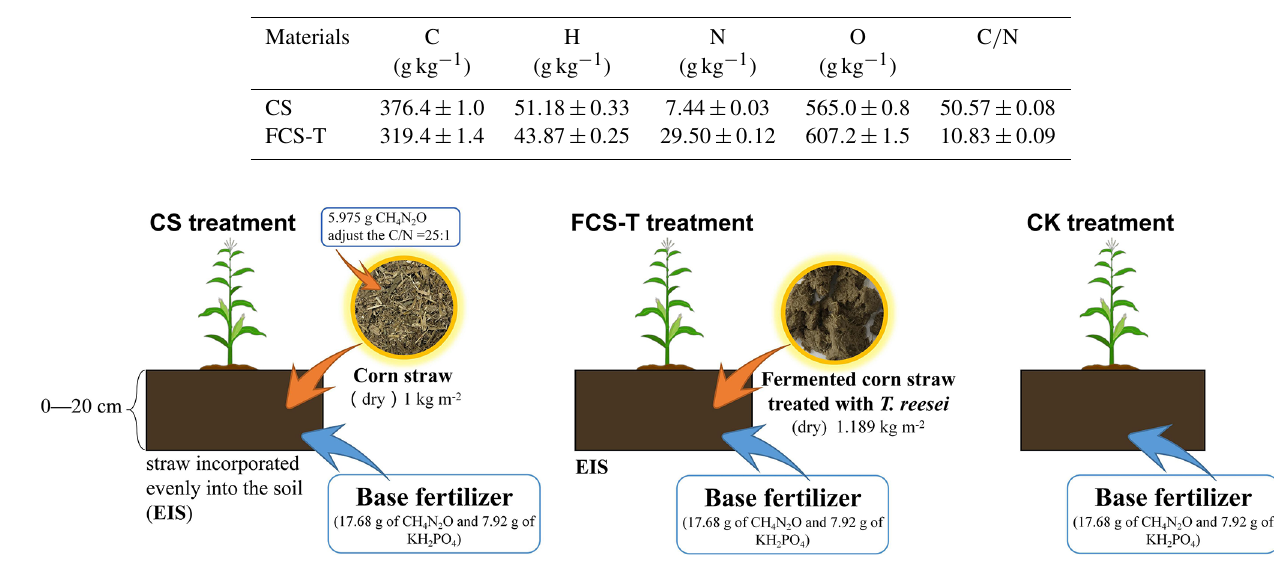
Figure 1. Schematic diagram of three different treatment methods in the